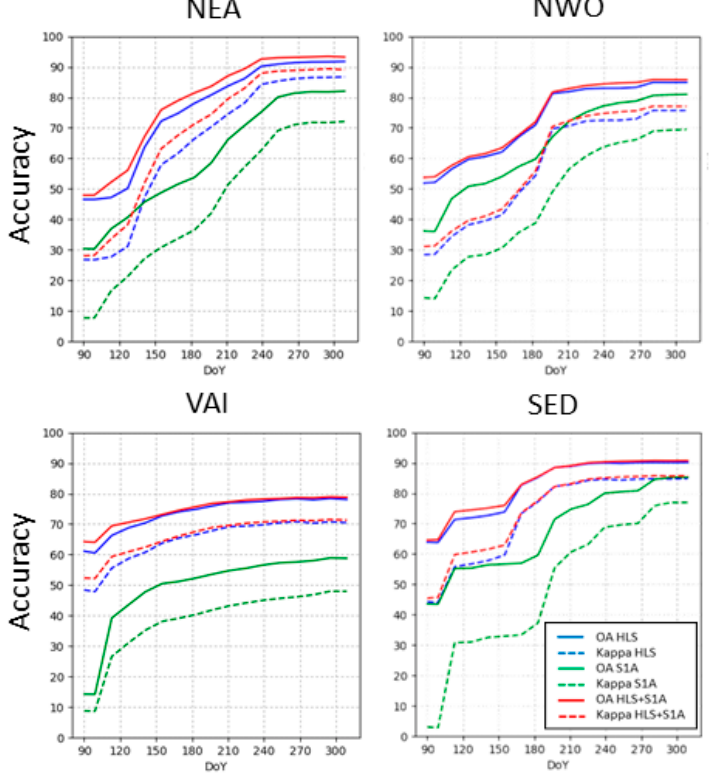
Figure 7. The overall accuracy and kappa values by sensor types over the crop season in the four case study regions. study